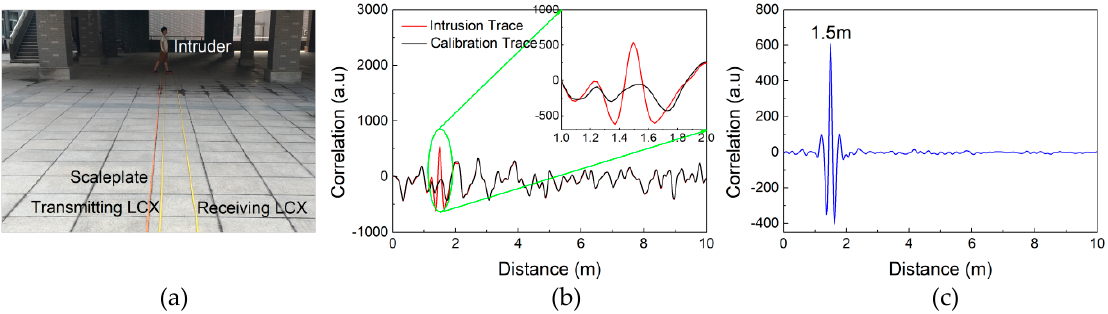
Figure 5. ( a ) Experimental scene of intrusion detection. ( b ) Detection results before and after ( c ) Final intrusion detection result.